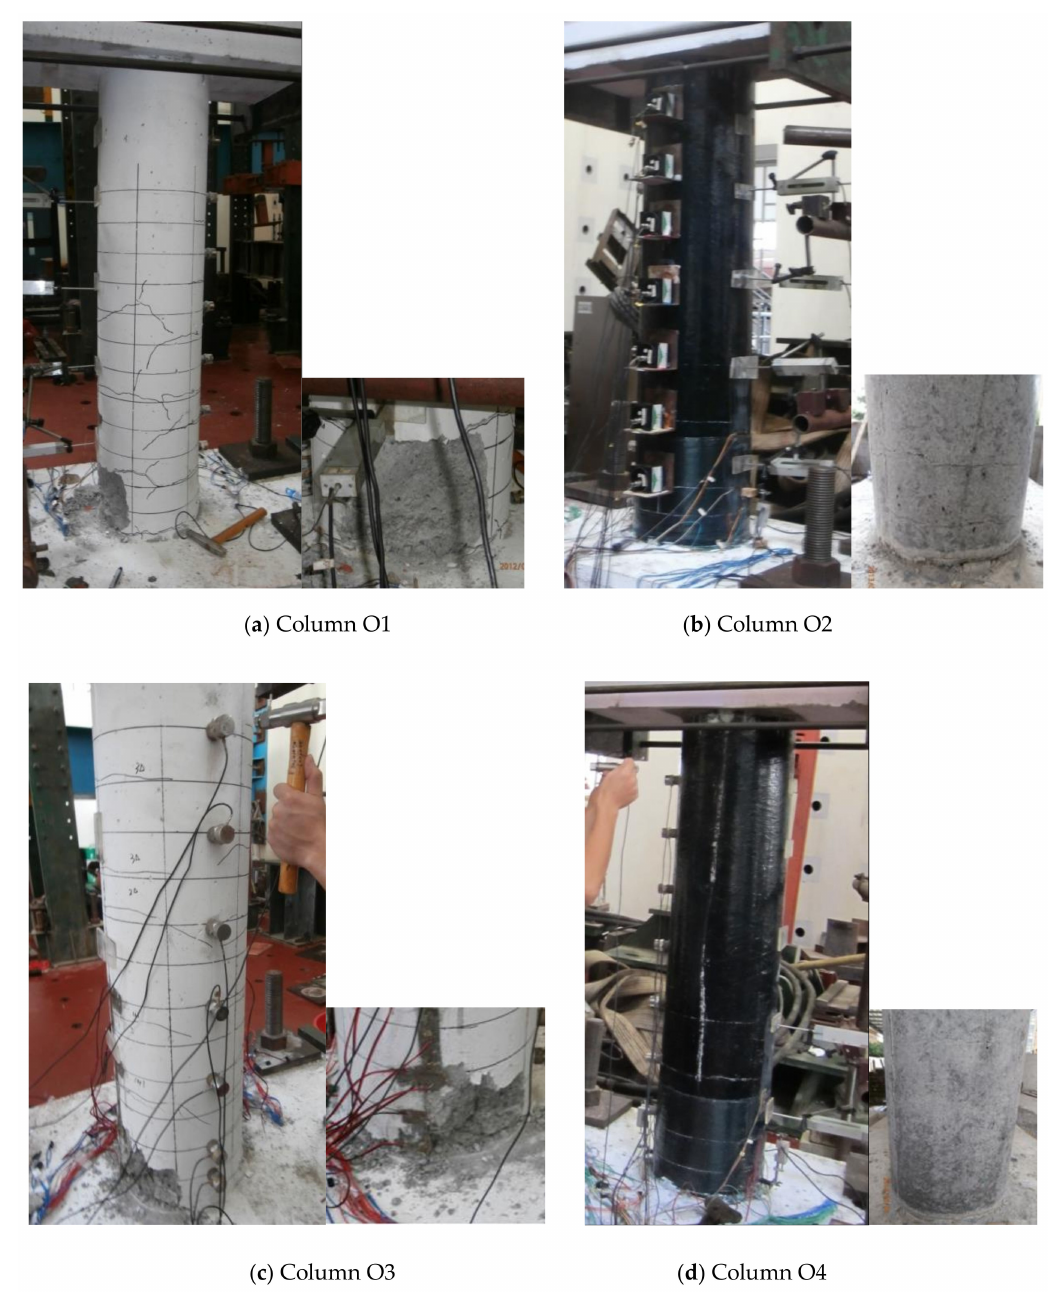
Figure 6. Ultimate failure modes of the original